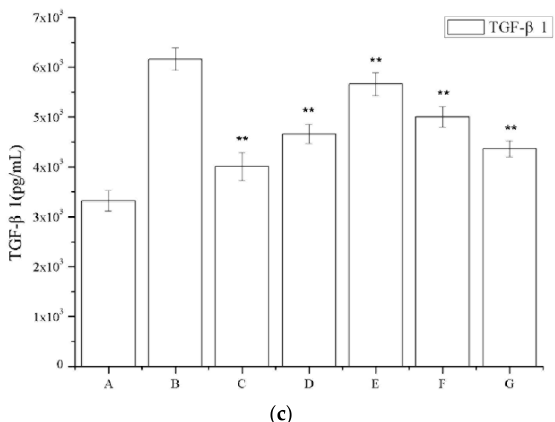
Figure 6. Effects of periostracum cicadae on the levels of TGF-β1 in the kidney. ( a ) Representative immunohistochemistry image. A: Normal, healthy control group; B: IgAN model group; C: prednisone acetate group; D: tripterygium glycoside tablet group; E–G: treatment group that received